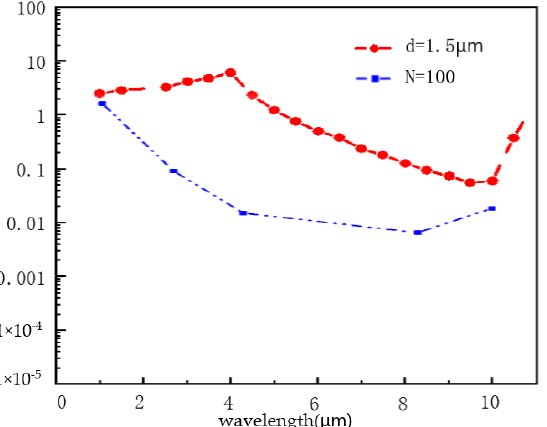
Figure 15. Comparison of the extinction factors in the simulation between the SiC elementary particles and cluster particles with the same “particle” size.